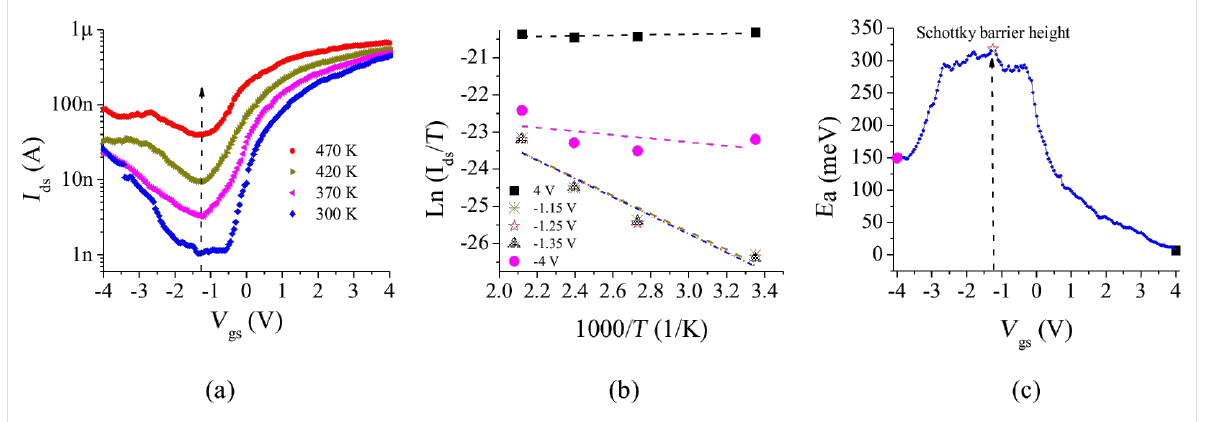
Figure 4: The procedures for determining the Schottky barrier height. (a) CNFET transfer characteristics measured at different temperatures. (b) Arrhenius plot with linear fits for different gate biases, V gs . For the better visualization, only the data points obtained for five different gate voltages: 4 V, − 1.15 V, − 1.25 V, − 1.35 V, − 4 V are shown. (c) Activation energy ( E a ) as a function of gate bias ( V gs ) estimated from (a). The highlighted data points represent the activation energies derived from the corresponding slopes of linear fits in